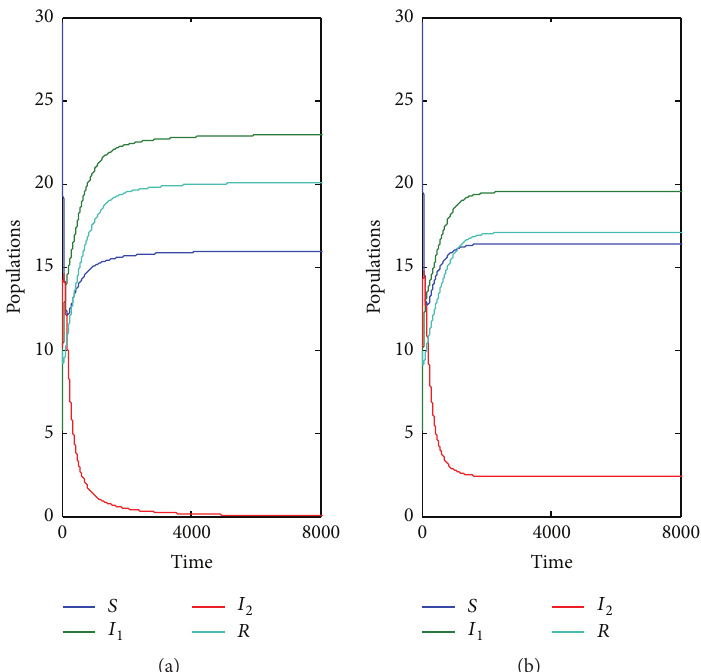
Figure5:Timeseriesofthesolutionofmodel(1)forthedatagivenby(81).(a)For 𝑝 1 = 0.6 themodelapproachesto 𝐸 2 = (15.9, 22.9, 0, 20.08) . (b) For 𝑝 1 = 0.5 the model approaches to 𝐸 3 = (16.4, 19.5, 2.40, 17.06)